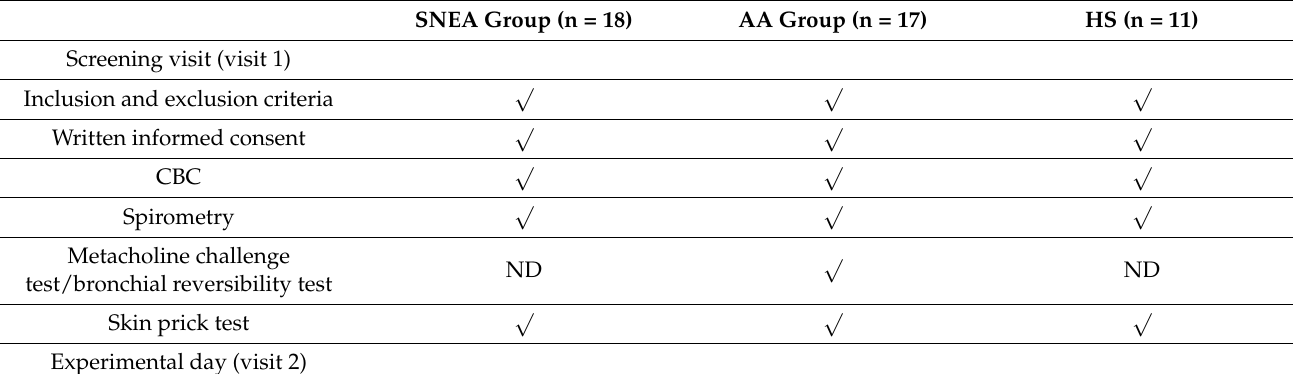
Table 2. Research